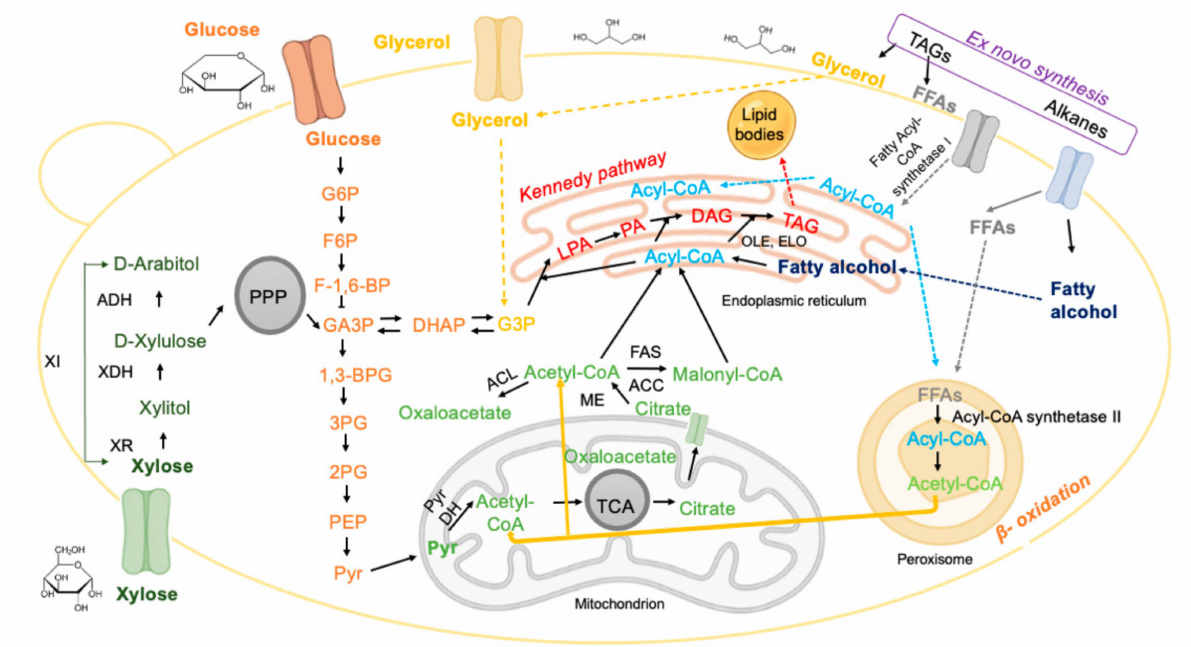
Figure 2. Lipid biosynthesis pathways in oleaginous yeasts. The pathways involved in lipid synthesis (de novo and ex novo synthesis) are summarised in this figure. The explanation of each step of the pathway is described in the main text. Abbreviations: ACC, Acetyl-CoA carboxylase; ACL, ATP- citrate lyase; ADH, alcohol dehydrogenase; 1,3-BPG, 1,3-bisphosphoglycerate; DAG, diacylglycerol; DHAP, dihydroxyacetone phosphate; ELO, Elongase; ER, endoplasmic reticulum; F6P, fructose- 6-phosphate; F-1,6-BP, Fructose 1,6-bisphosphate; FAS, fatty acid synthase; FFA, free fatty acids; G6P, glucose-6-phosphate; G3P, glycerol-3-phosphate; GA3P, glyceraldehyde-3-phosphate; LPA, lysophosphatidic acid; OLE, desaturase; 2PG, 2-phosphoglycerate; 3PG, 3-phosphoglycerate; PA, phosphatidic acid; PEP, phosphoenolpyruvate; PPP, pentose phosphate pathway; Pyr, pyruvate; Pyr DH, pyruvate dehydrogenase; TAG,